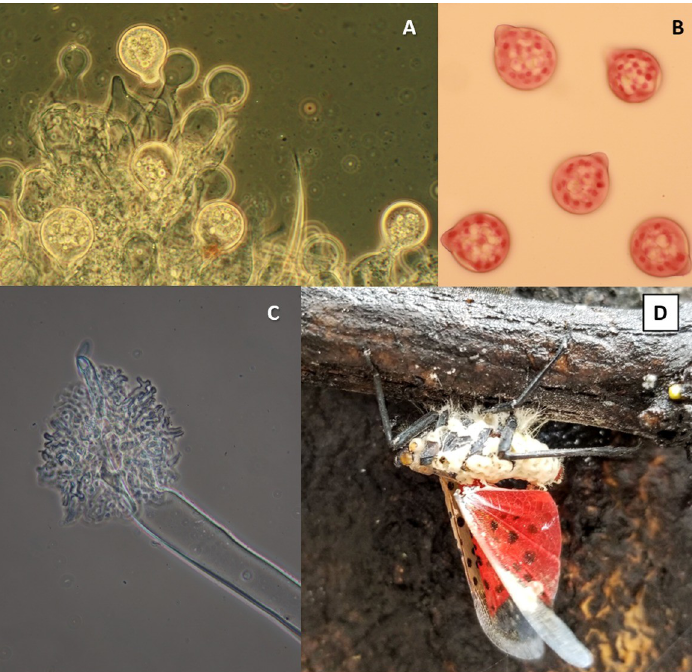
Fig 1. Micromorphology of Batkoa major . A . Conidiophores with conidia. Conidia average 41.5 μ m wide x 49.3 μ m long. B . Multinucleate conidia (nuclei stained with aceto-orcein). C . Distal end of rhizoid with holdfast. D . Cadaver of the spotted lanternfly attached to a twig by rhizoids (Photo by E.H. Clifton).